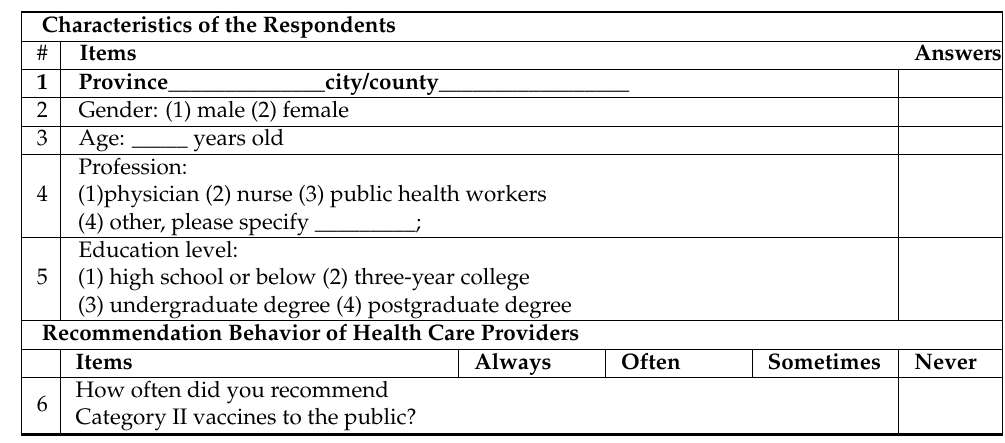
Table A2. The questionnaire used in the quantitative